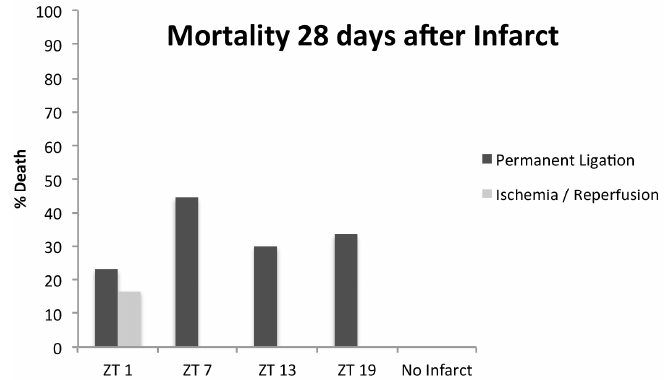
Figure 1. Mortality in the 28 days after the infarct. Thirteen mice died, of which 0 underwent sham, 1 ischemia/reperfusion (IR), and 12 permanent ligations (PLs). In the PL group, mortality was highest in the ZT 7 group, although differences were not statistically significant. ZT, Zeitgeber Time (ZT0 = lights on).